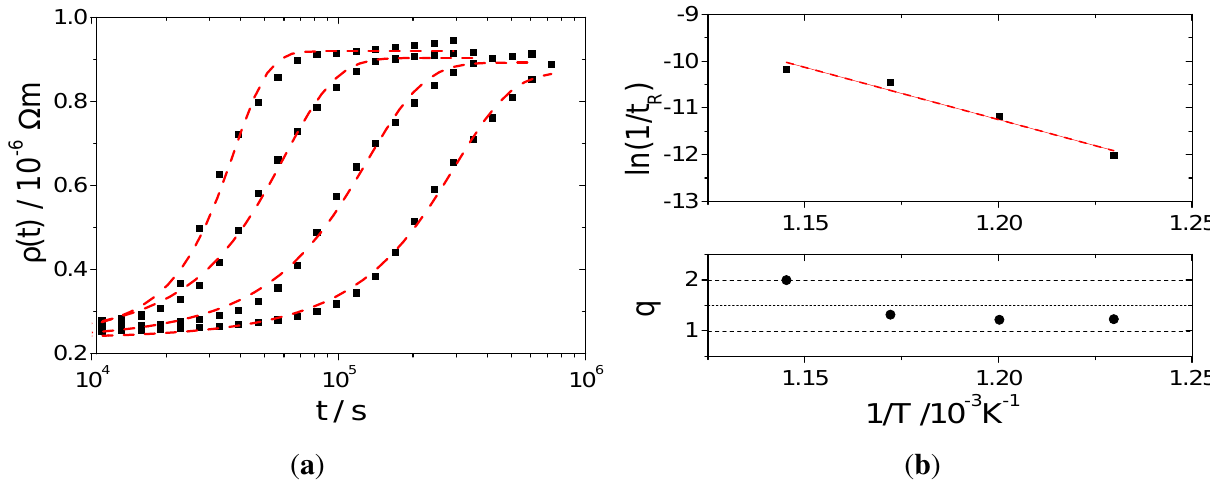
Figure 7. ( a ) JMAK fits (dashed red lines) of the data from Figure 5b, indicated here as filled squares without showing all data for clarity reasons; ( b ) Arrhenius plot of the parameter t from Equation 2 and the time exponent q from the same equation plotted to the same